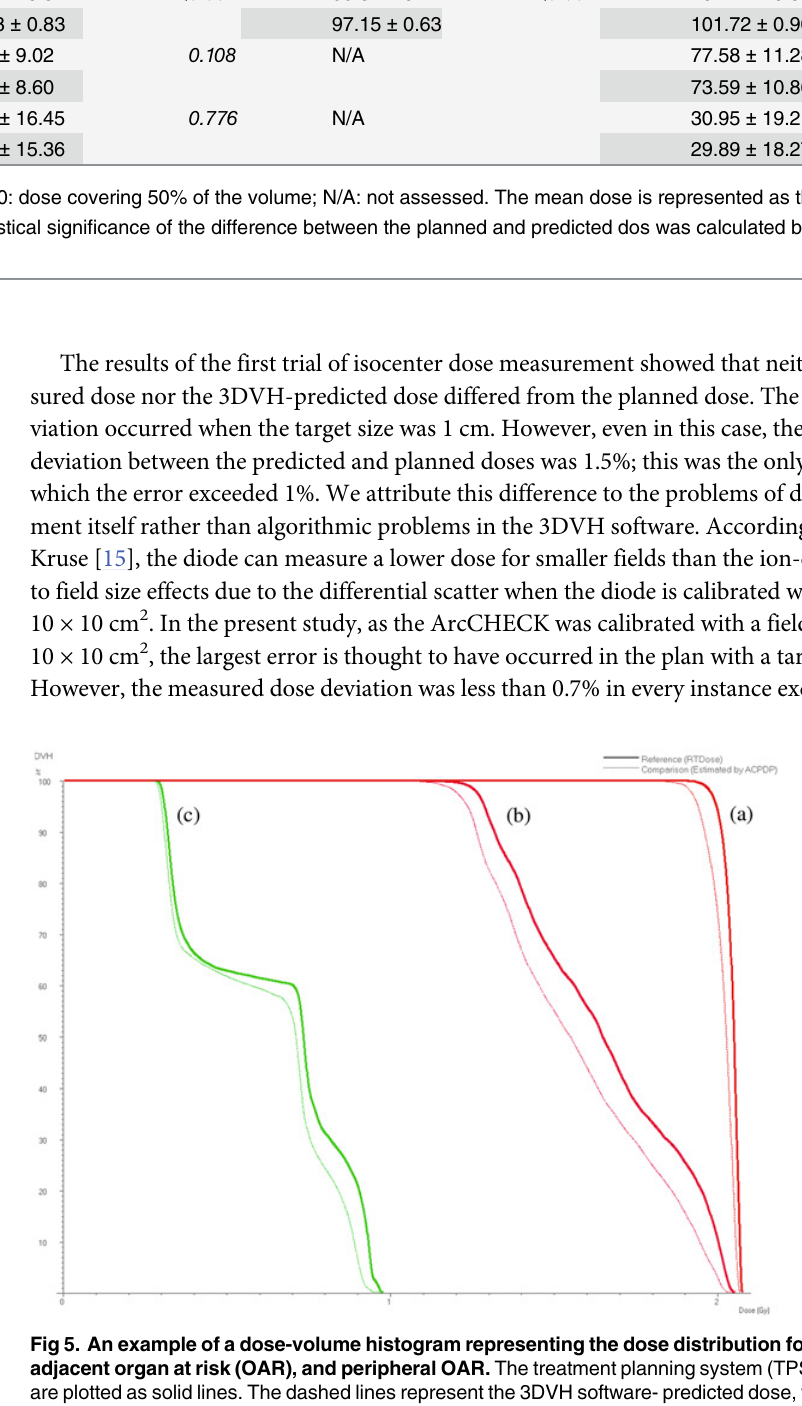
Table 5. Comparison of the various dose-volume parameters between the treatment planning system (TPS)-planned dose and the 3DVH-predicted dose.